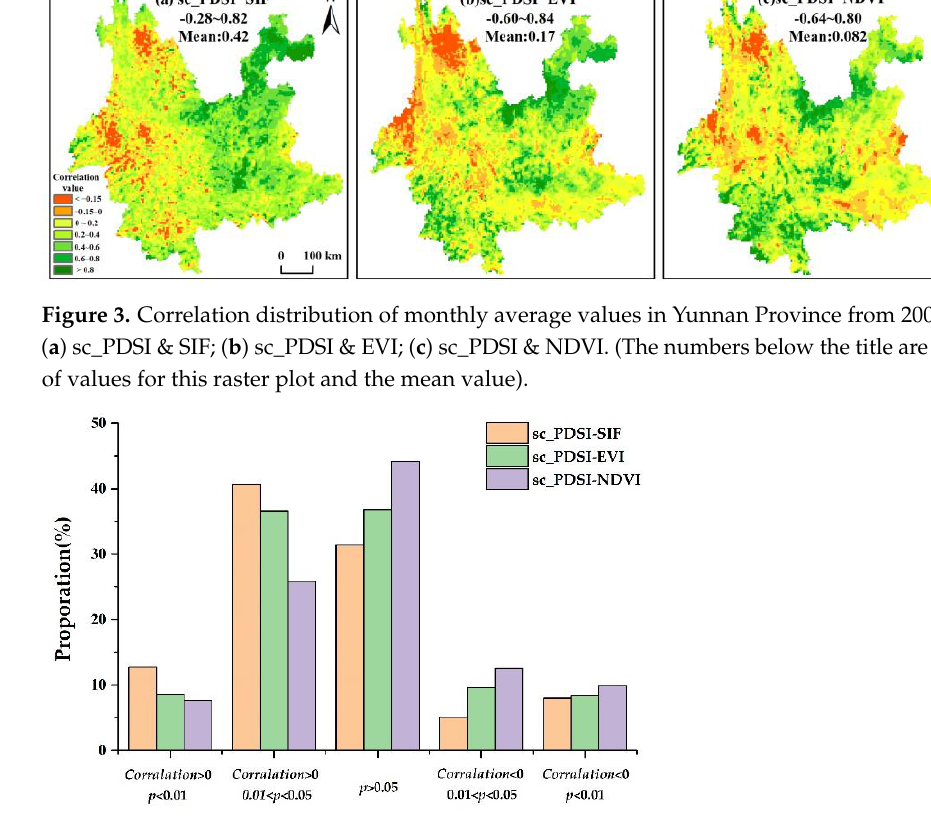
Figure 4. Percentage of SIF, EVI, NDVI and sc_PDSI significance tests in Yunnan Province, 2009 – 2011.